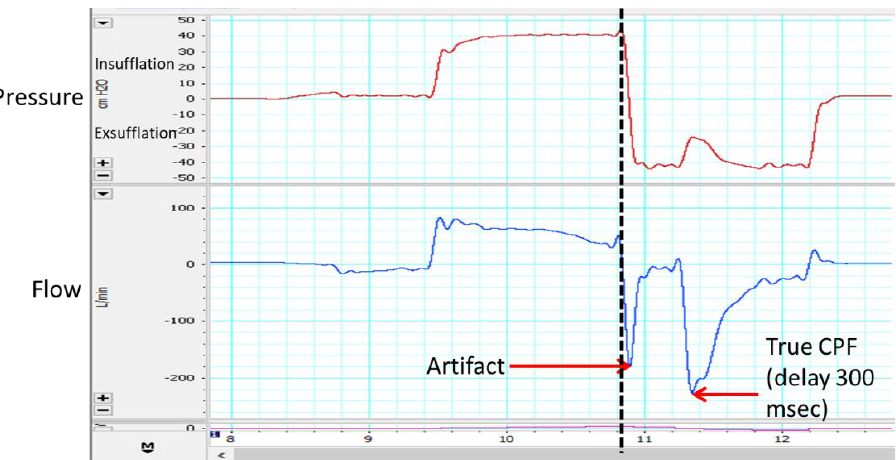
Figure 5. Shows pressure (red) and flow (blue) traces during a cycle of mechanical insufflation exsufflation with a patient coughing. The first negative flow point is artifact as it is the compressible volume. The second peak is the true cough peak flow (CPF). With thanks to Manuel Lujan.